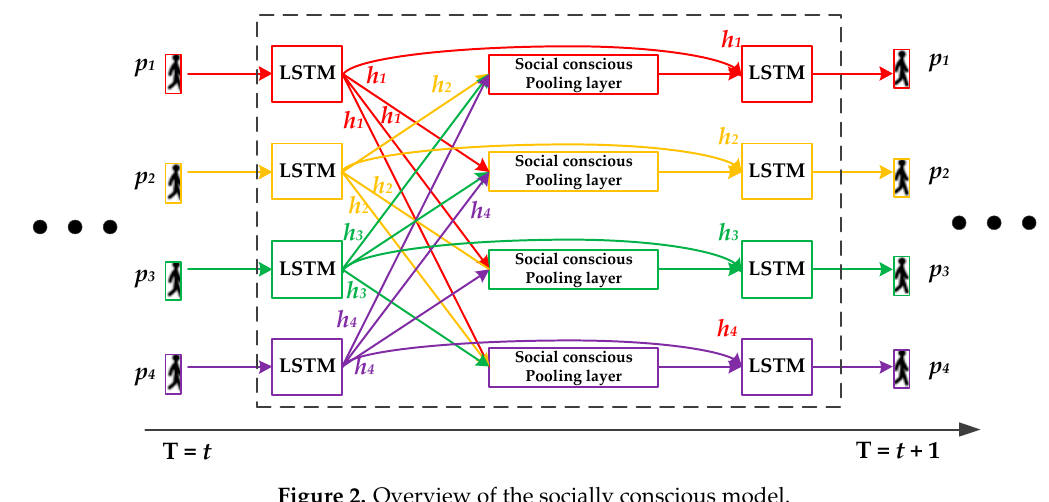
Figure 2. Overview of the socially conscious model.